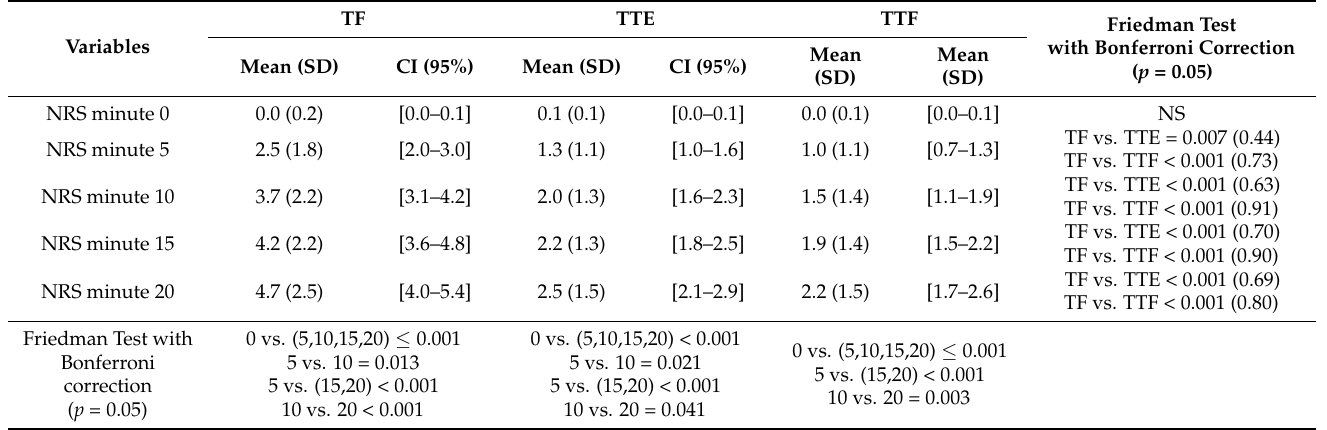
Table 3. Results of Numeric rating scale (NRS). ( n = 56; 2